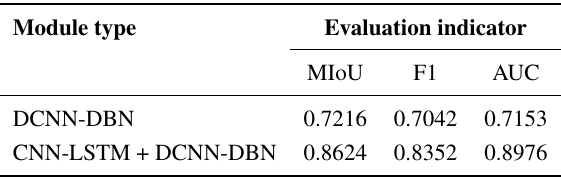
Table 4. Temporal phase fusion module validation experimental results.